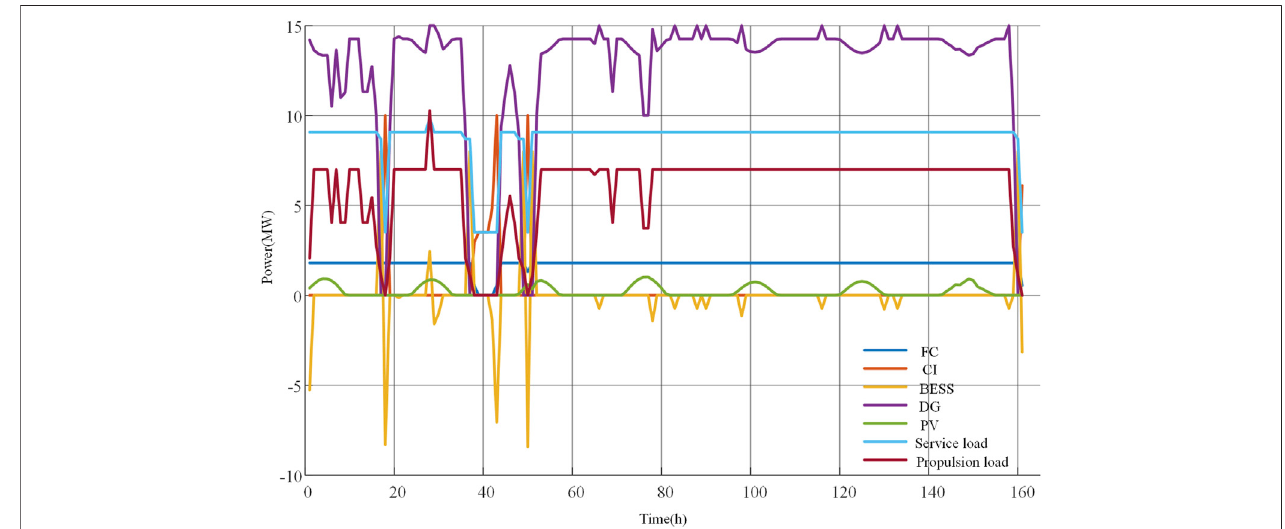
FIGURE 8 | Generation scheduling of shipboard power system.